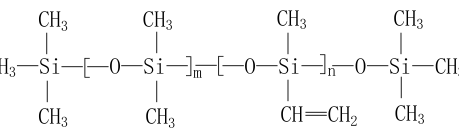
Figure 2. Schematic diagram of increase of PDMS molecular chain. The number of oligomer chain links on the left side of Figure 2 is marked as 1, and the yellow part was one 3 2 Si CH O    （ ） chain link. The red on the right side of Figure 2 was the chain link which has been added. After the increase, the number of oligomer chains on the right was recorded as 2. Finally, a total of 13 PDMS molecular chain models were built, and the number of chain links was 1–8, 10, 12, 14, 16, and 18. The molecular model of PDMS oligomer with 18 molecular chain links is shown in Figure 3. Figure 3. Molecular model diagram of dimethylsiloxane oligomer with chain number of 18. The simulation uses the DMol3 module in Materials Studio; the basis set is B3LYP, the temperature was 298 K, the electric field was 0.001 a.u., and the dipole moment was calculated. After calculating the number of dipole moments, we used the Clausius–Mosotti equation to calculate the dielectric constant [18,19]. The calculation equation is shown in the Equation(3)